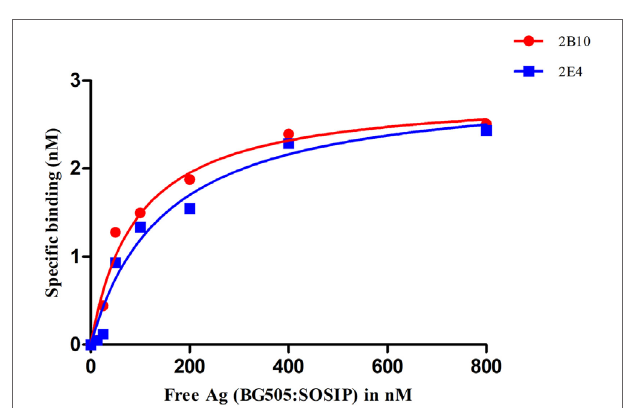
FigUre 5 | Analysis of the binding affinity of 2B10 and 2E4 scFvs by ELISA. Different dilutions of BG505:SOSIP.664 gp140 (10–800 nM) were incubated with fixed concentration of the two scFvs and unbound antibody was detected by ELISA. The experiment was repeated at least twice. Saturation binding curve was plotted between free antigen Vs specific binding through non-linear regression